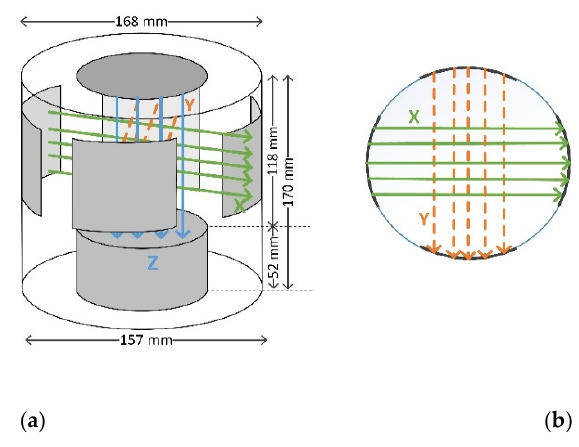
Figure 3. Electrode configuration: ( a ) 3D schematic, ( b ) top view.